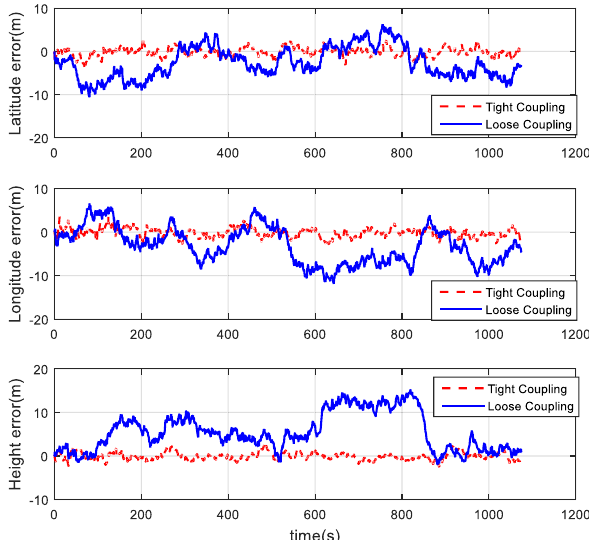
Figure 17. Position error comparison of tight and loose coupling.